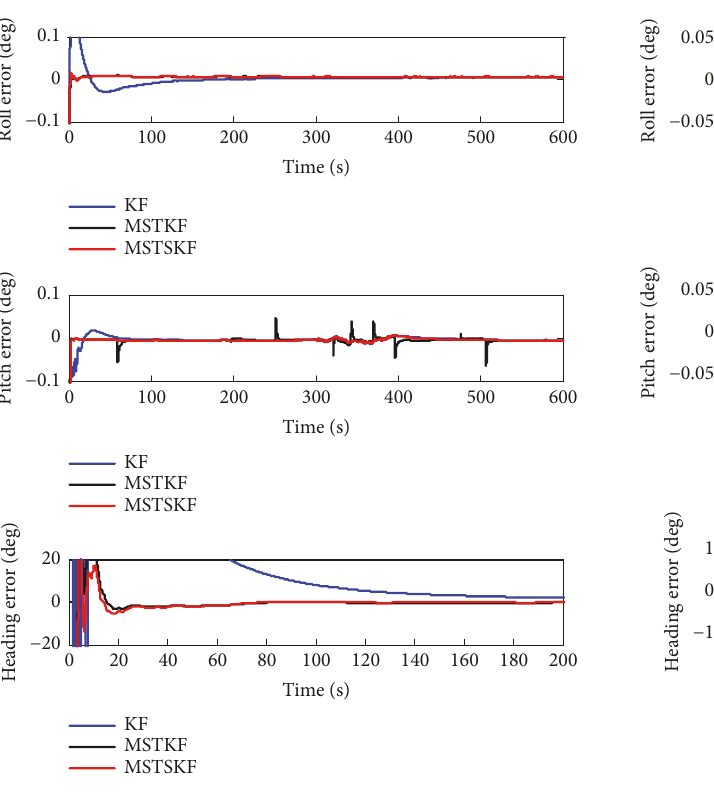
Figure 7: Attitude angle error of the experiment when the system noise covariance matrix is magnified 50